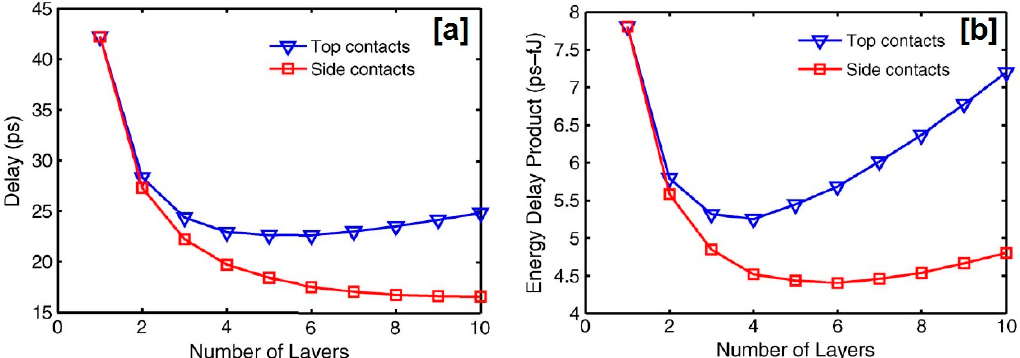
Figure 18. ( a ) Delay versus number of layers and ( b ) energy delay product (EDP) versus number of layers for top and side contacts [3]. Reproduced with permission from [3]. IEEE, 2013.